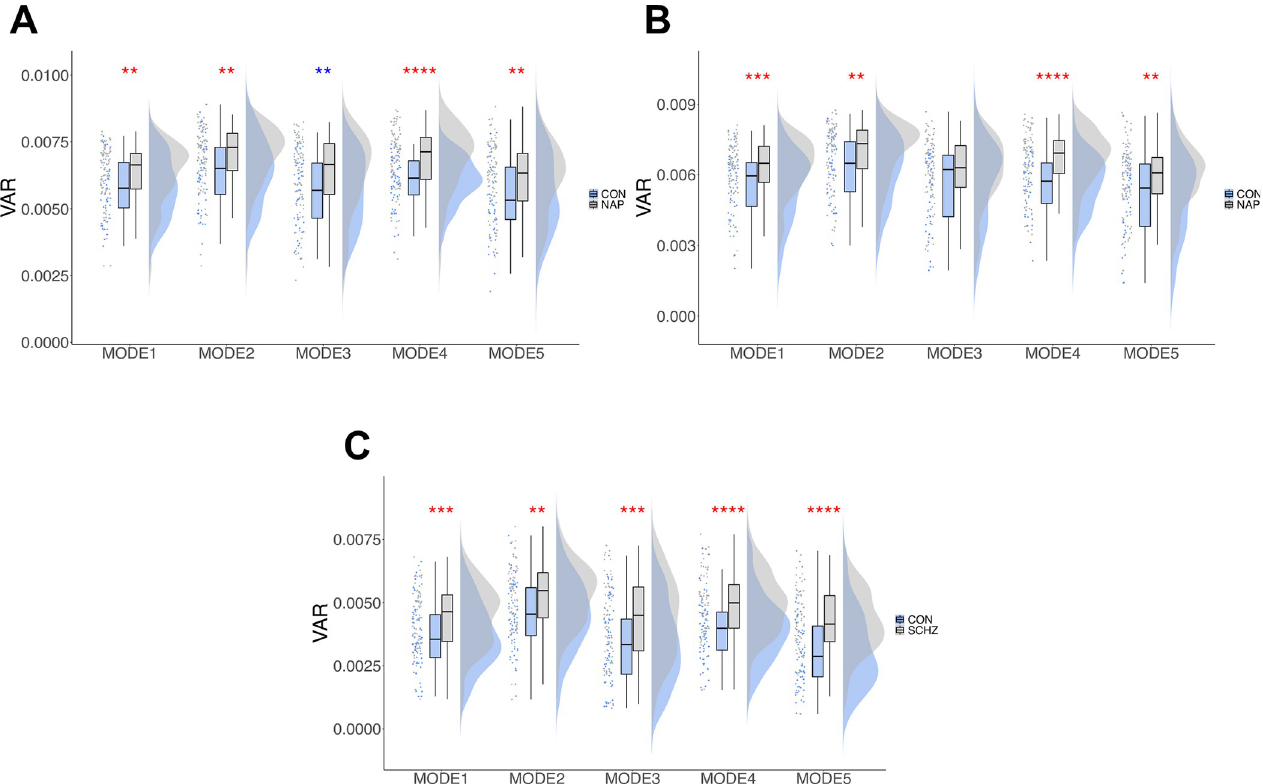
Fig 4. Most significant group differences in local VAR in the modes for HCPEP and Cobre datasets. Raincloud plots show from left to right the raw data, boxplots showing the median, upper and lower quartiles, upper and lower extremes, and the distributions of the raw data. A) HCPEP RUN1. B) HCPEP RUN2. C) Cobre dataset. � = 0.05, �� = 0.01, ��� = 0.001, ���� < 0.001. Red � effect size between groups greater than effect size between runs. Blue � effect size between groups less than largest effect size between